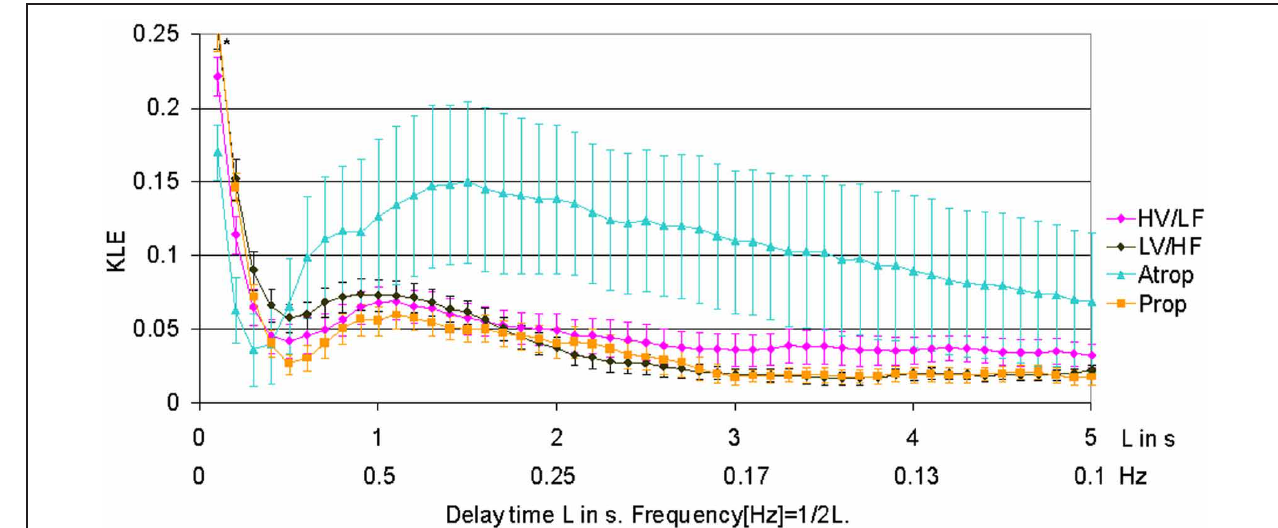
a subtle increase in complexity on time scales associated with both vagal and sympathetic modulations of fHRV. The HV/LF curve (lower complexity) lies